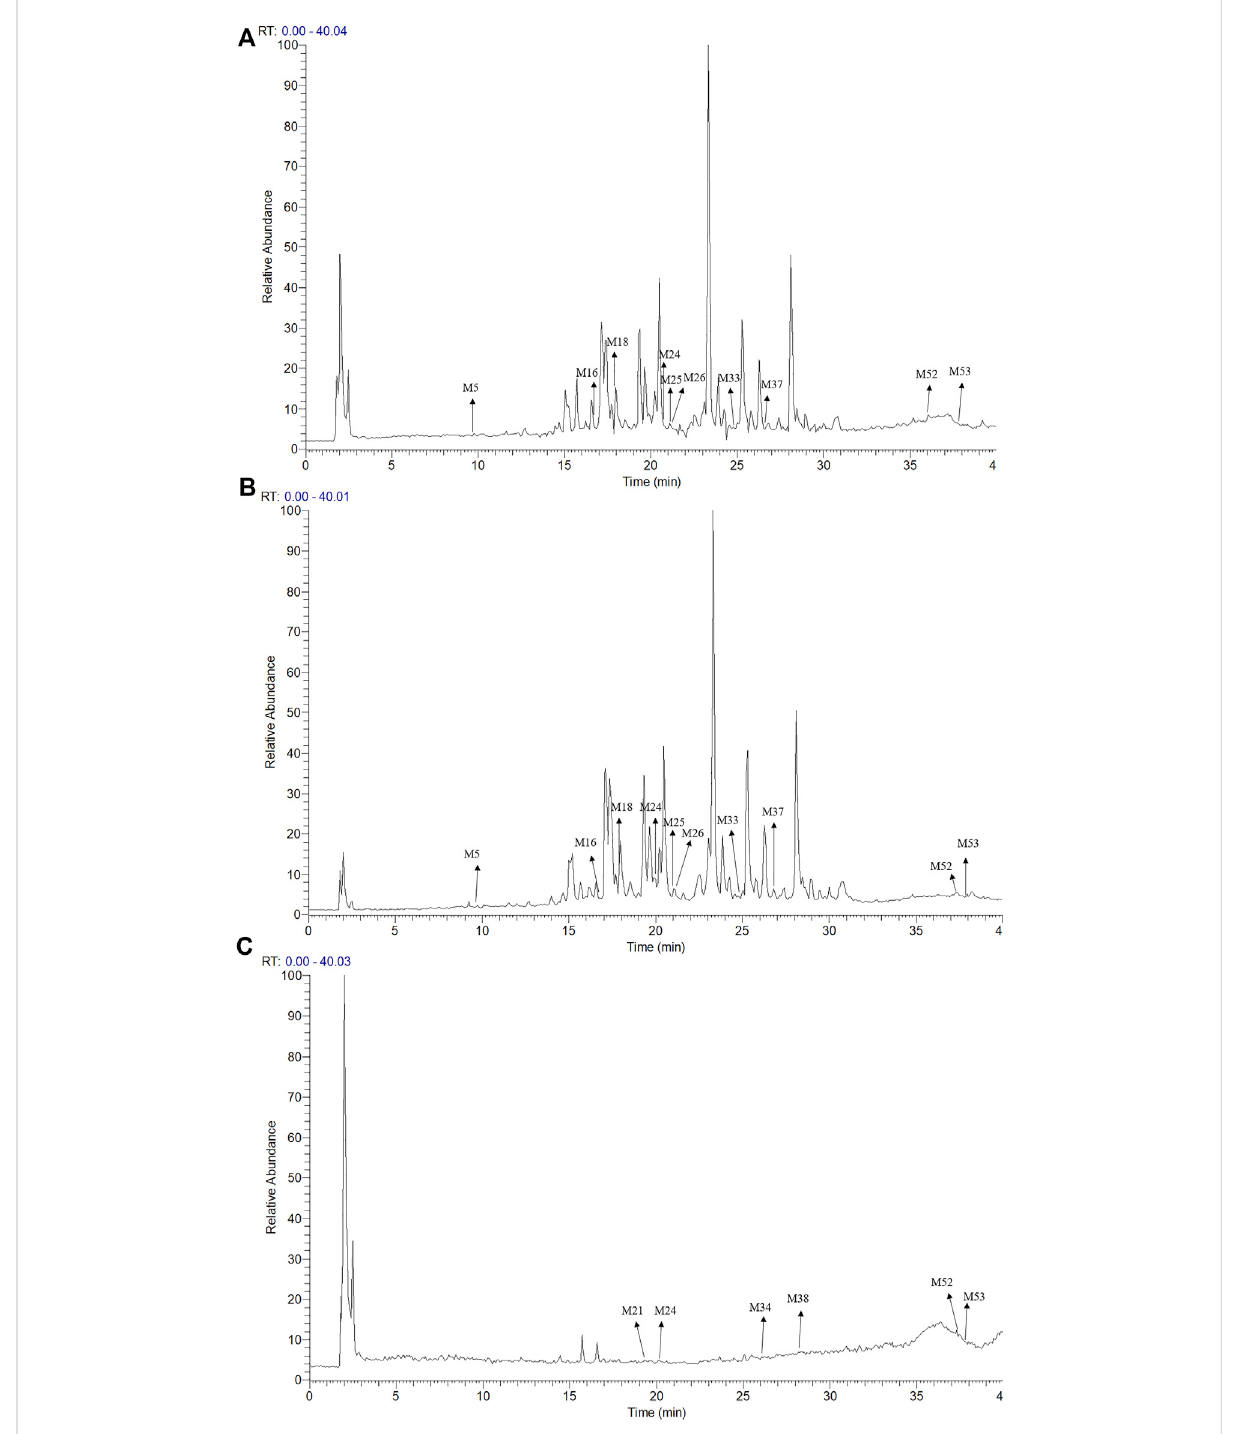
FIGURE 4 TIC chromatograms in the positive mode; (A) CR-SR extract, (B) CR extract, and (C) SR